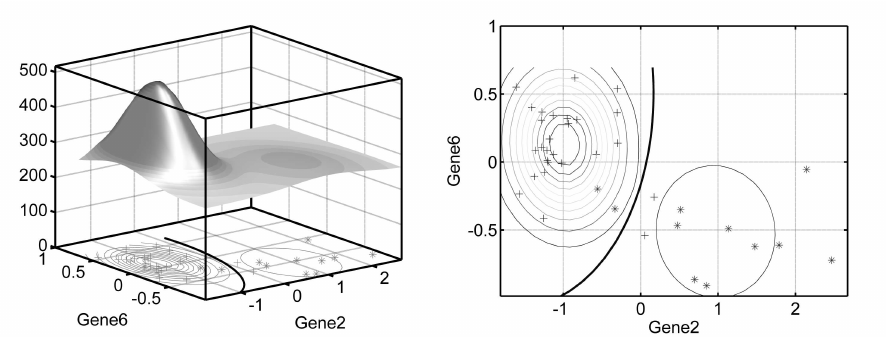
r s = 0.2 and = 0.5; apparent